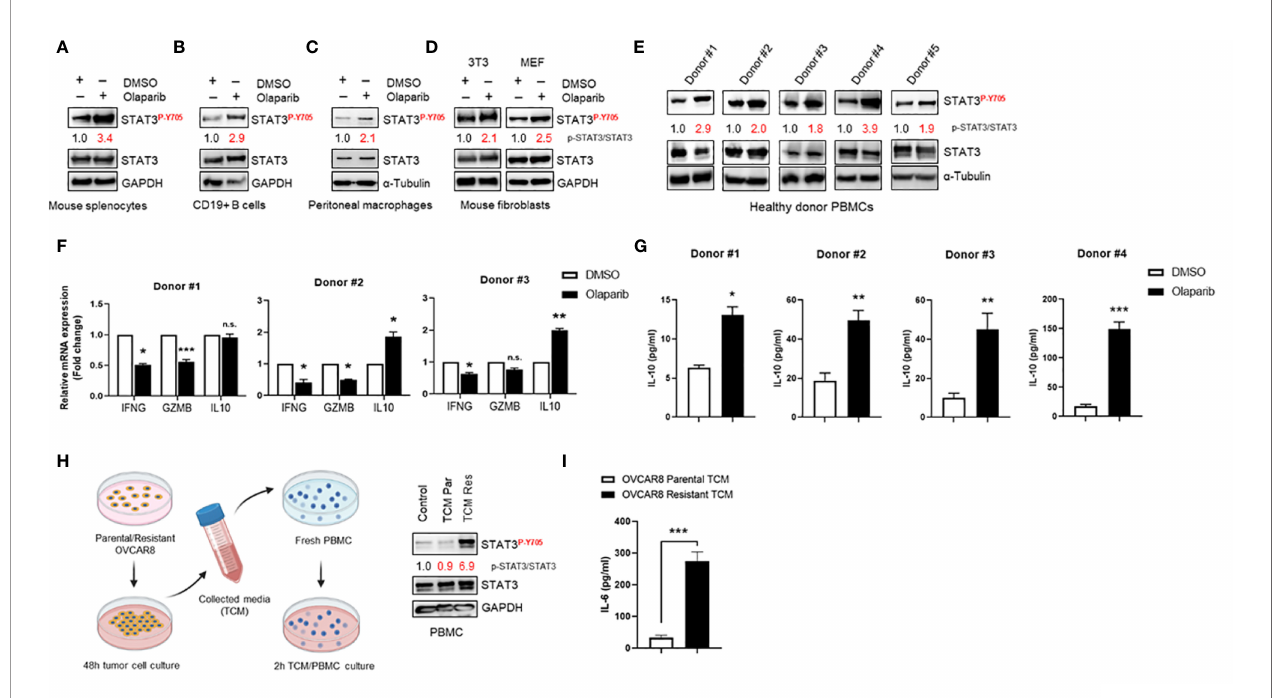
FIGURE 4 | Olaparib activates STAT3 in fi broblasts and immune cells, suppressing immune responses (A – D) Western blot showing activated (P-Y705) and total STAT3 levels after Olaparib in freshly isolated splenocytes, CD19+ B cells, and bone marrow-derived macrophages from naive mice, as well as in 3T3 and MEF fi broblasts after treatment with DMSO or 10 µM Olaparib for 24 h. Numbers on the blot show relative activated (P-Y705) vs. total STAT3 ratios as determined by ImageJ. Shown are representative blots of three (A, D) or two (B, C) independent experiments. GAPDH and a -Tubulin staining served as a loading control. (E) Western blotting showing activated (P-Y705) in freshly isolated human PBMCs from fi ve healthy donors treated either with DMSO or 10 m M Olaparib for 48 h. Relative p-STAT3/STAT3 ratios were determined by ImageJ and are shown. a -Tubulin staining served as a loading control. (F) Real-time PCR measuring immunostimulatory IFNG, GZMB and immune-suppressive IL10 mRNA levels in human PBMCs from three different donors treated either with DMSO or 10 m M Olaparib for 48 h. Gene expression was normalized to the housekeeper gene ACTB and relative expressions against vehicle controls are shown. Unpaired two-tailed Student t-test of Olaparib treatment performed against DMSO controls. Shown are means ± SD (n = 3). *p<0.05, **p<0.01, and ***p<0.001. (G) ELISA assessing IL- 10 production in the indicated donor PBMC cultures treated either with DMSO or 10 m M Olaparib for 48 h. Unpaired two-tailed Student t-test of Olaparib treatment performed against DMSO controls, shown are means ± SD (n = 3). *p<0.05, **p<0.01, and ***p<0.001 (H) . Diagram showing the tumor-conditioned medium (TCM) transfer system (right). Parental or Olaparib-resistant OVCAR8 cells were plated in a 10-cm dish and incubated for 48 h. The supernatant was transferred to a 50-ml centrifuge tube and centrifuged for 5 min. Fresh PBMCs were serum-starved for 24 h, incubated with TCM from parental (TCM Par) or Olaparib-resistant (TCM Res) OVCAR8 cells for 2 h and whole cell lysates were analyzed by Western blotting showing activated (P-Y705) in human PBMCs following TCM incubation (left). For the control, full-serum media was added to PBMCs for 2 h. Activated (P-Y705) vs. total STAT3 ratios were determined by ImageJ. Data are representative of at least three independent experiments. GAPDH served as a loading control. (I) ELISA assessing IL-6 production in TCM from parental or Olaparib-resistant OVCAR8 cells. Unpaired two-tailed Student t-test of resistant TCM performed against parental controls, shown are means ± SD (n = 3). ***p<0.001, n.s., not signi fi